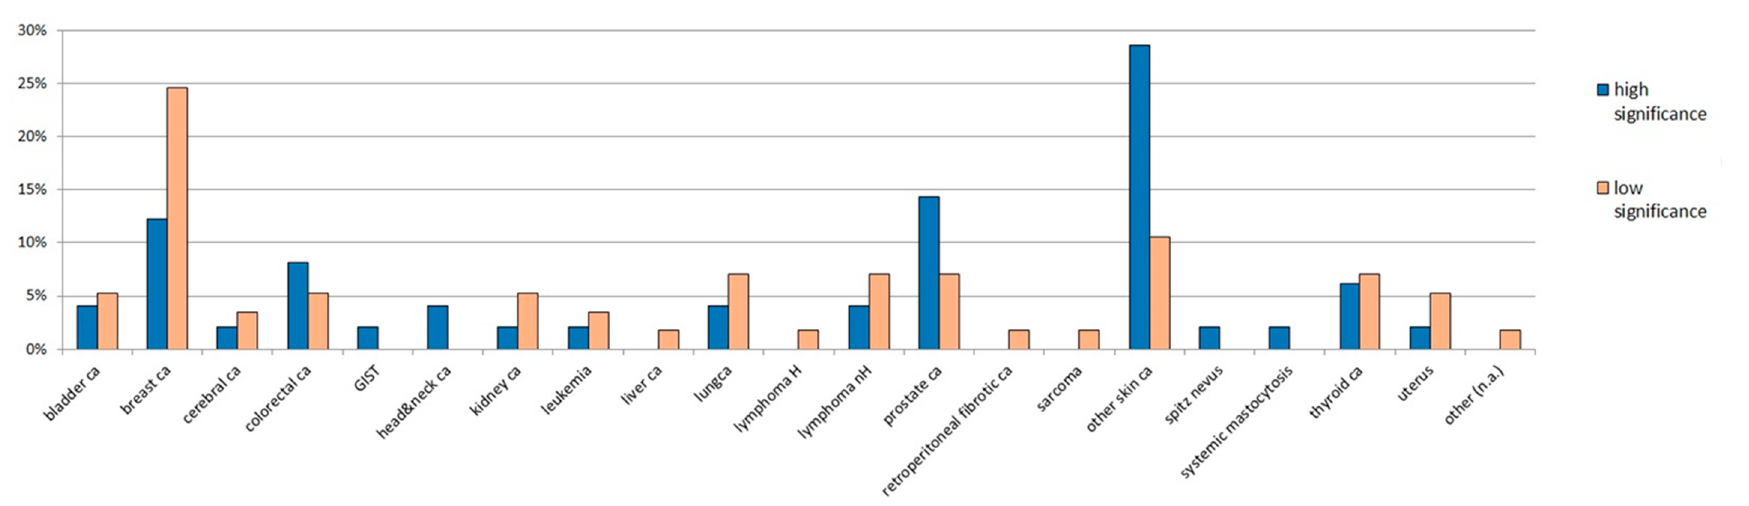
Figure 1. Distribution of other cancers than cutaneous melanoma in the patients’ cohort. The type of tumor is given on the x -axis, the percentage of patients is given on the y -axis. ca: cancer; H: Hodgkin; nH: non Hodgkin; n.a.: not assessed.